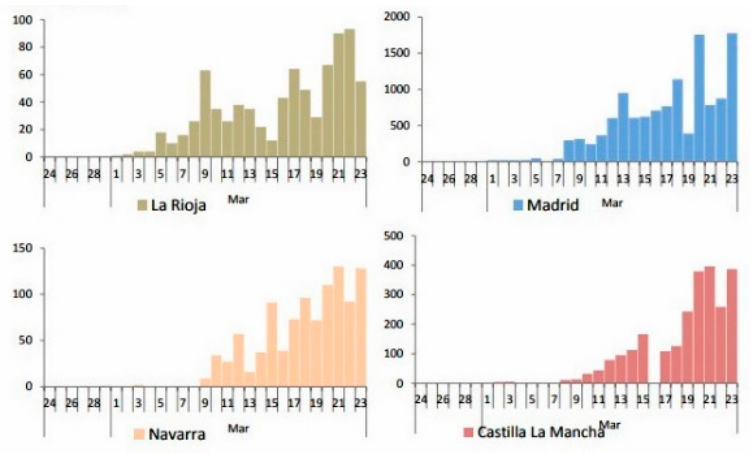
Figure 1. Supposedly comparative graphs of the expansion of coronavirus disease 2019 (COVID-19) in four Spanish autonomous communities [4].